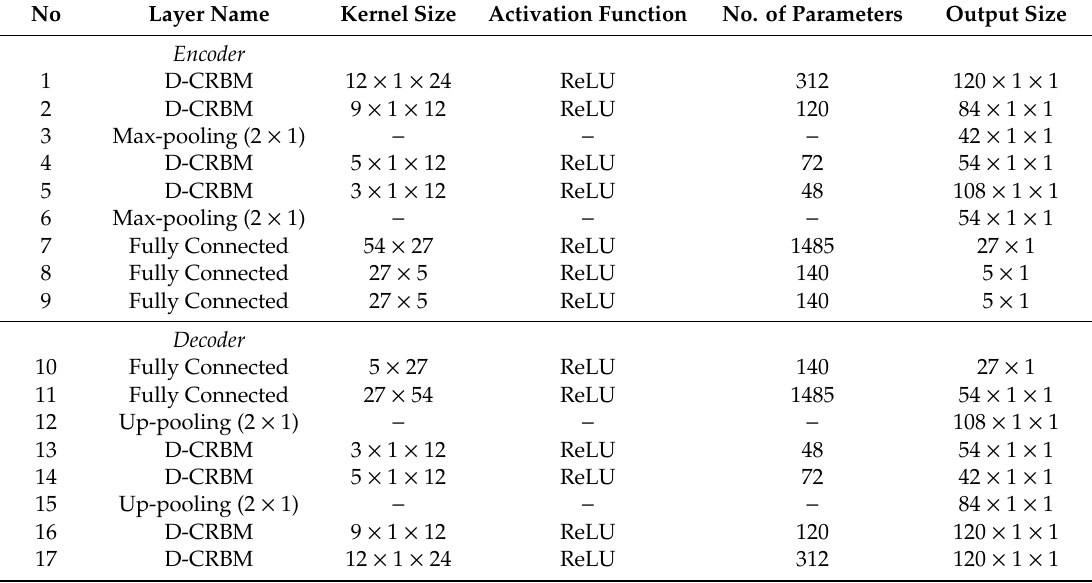
Table 1. Details of layers and parameters used for the CBN-VAE